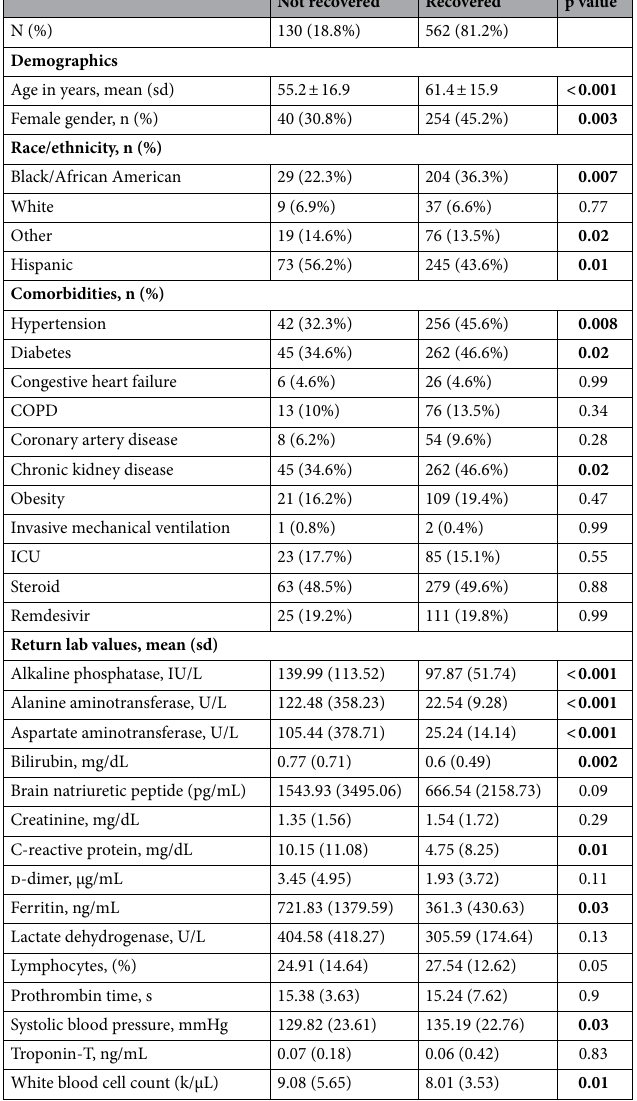
Table 4. Characteristics of patients 2 months after hospital discharge from COVID-19 stratified by absolute recovery and non-recovery from ALI. Group comparisons (recovery vs non-recovery) of categorical variables were performed using the Chi-squared test. Group comparison of continuous variables in means and standard deviations (sd) were performed using the Wilcoxon test. A p-value < 0.05t was considered statistically significant. Significant values are in